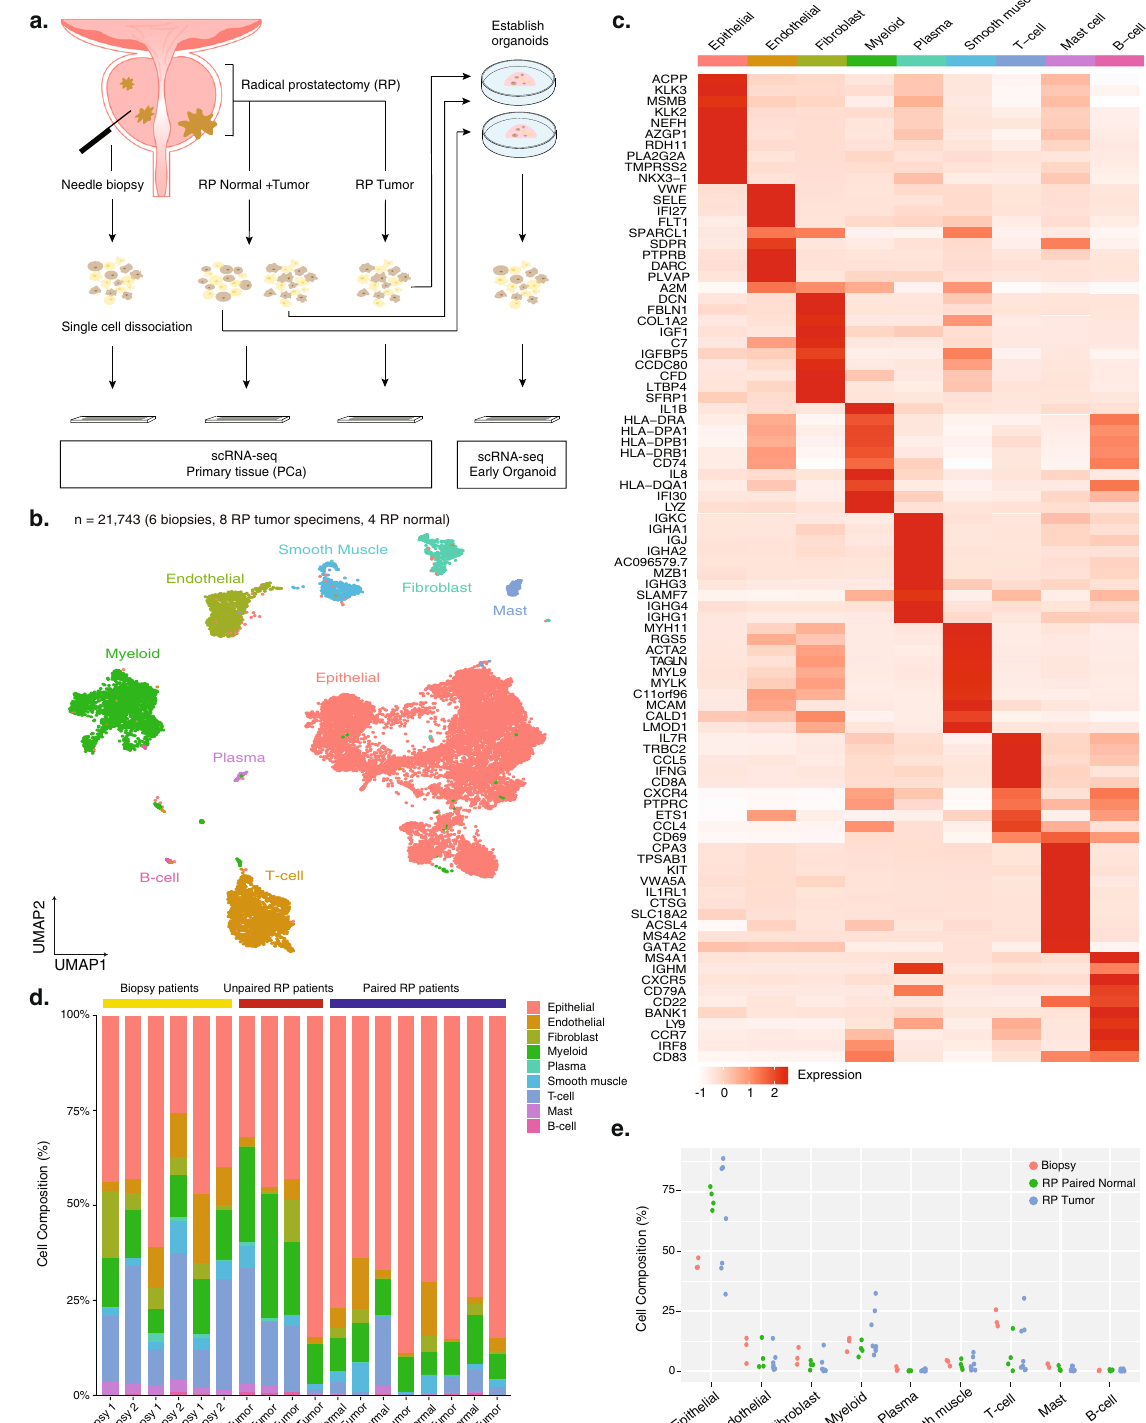
Paired RP patients